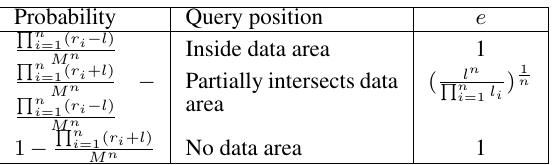
Table 4. Effectiveness of HistTree for n - n D query, l ≤ min increases. We assume r i are all random variables between 0 M